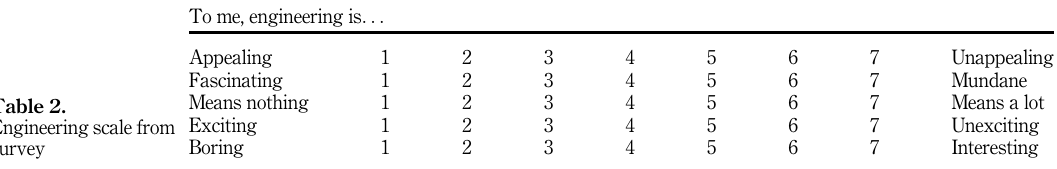
Table 2. Engineering scale from